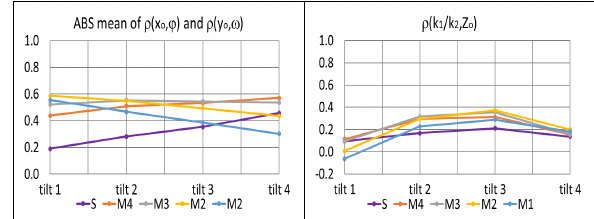
Figure 6. Left, mean absolute values of ρ (x o , φ ) and ρ (y o , ω ); right, mean values of [ ρ (k 2 , Z o )– ρ (k 1 , Z o )].